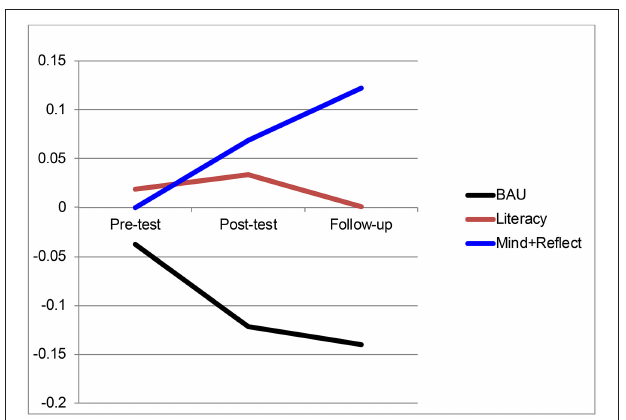
FIGURE 3 | HTKS performance as a function of time and condition. Bars represent standard errors. BAU, Business as Usual; Mind + Reflect, Mindfulness plus